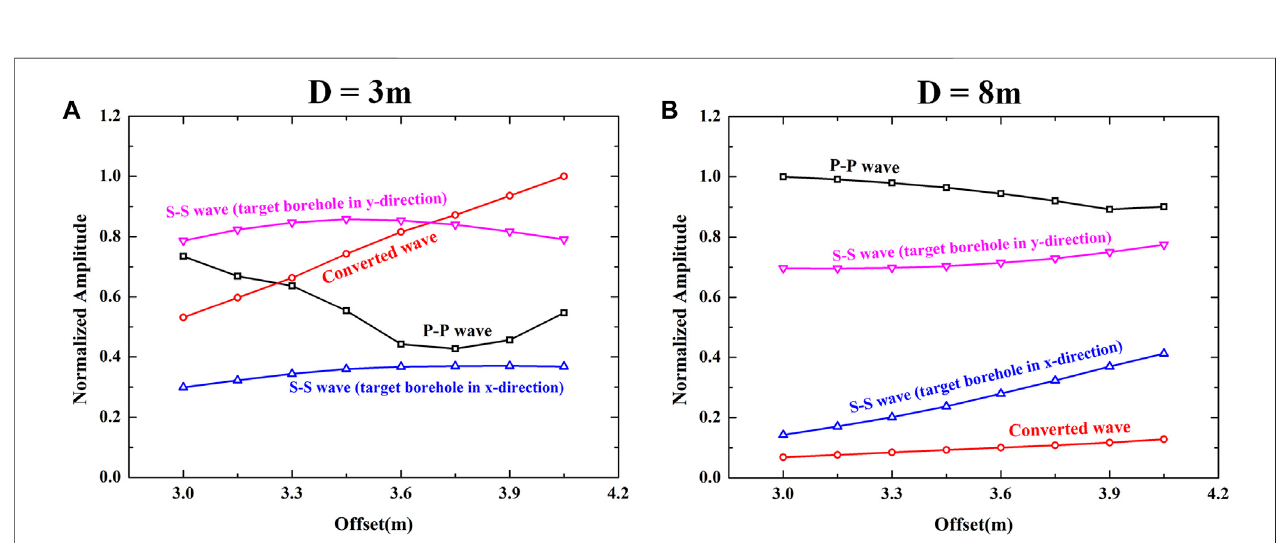
FIGURE 13 | The normalized amplitudes of different types of scattered waves received in the borehole. (A) and (B) show the amplitudes for the model when the distance between the measurement and target boreholes is 3 m and 8 m, respectively.